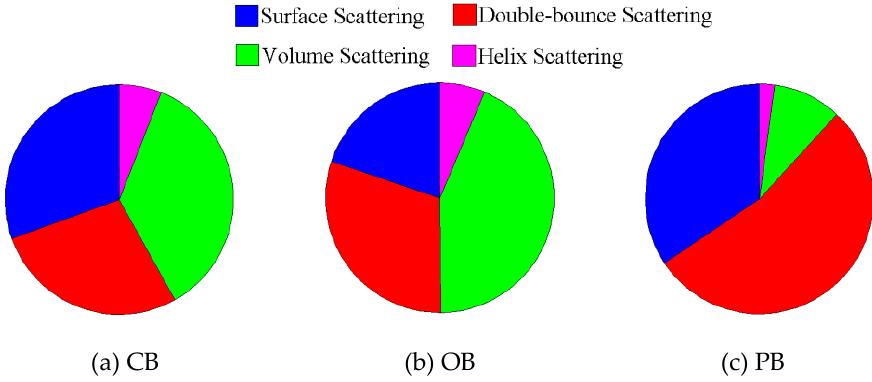
Figure 2. Relative contributions proportion of the four scattering mechanisms (SMs) from the Yamaguchi four-component decomposition (YFCD) method for the three kinds of building samples.